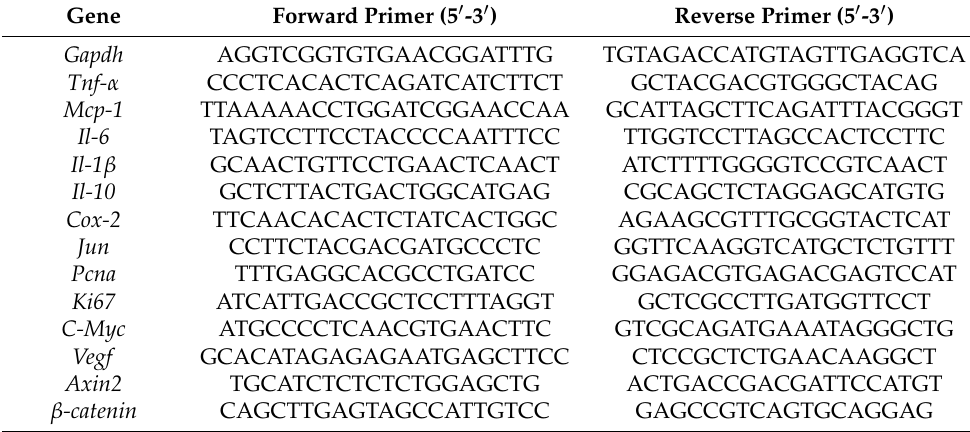
Table 3. Sequences of primers used in